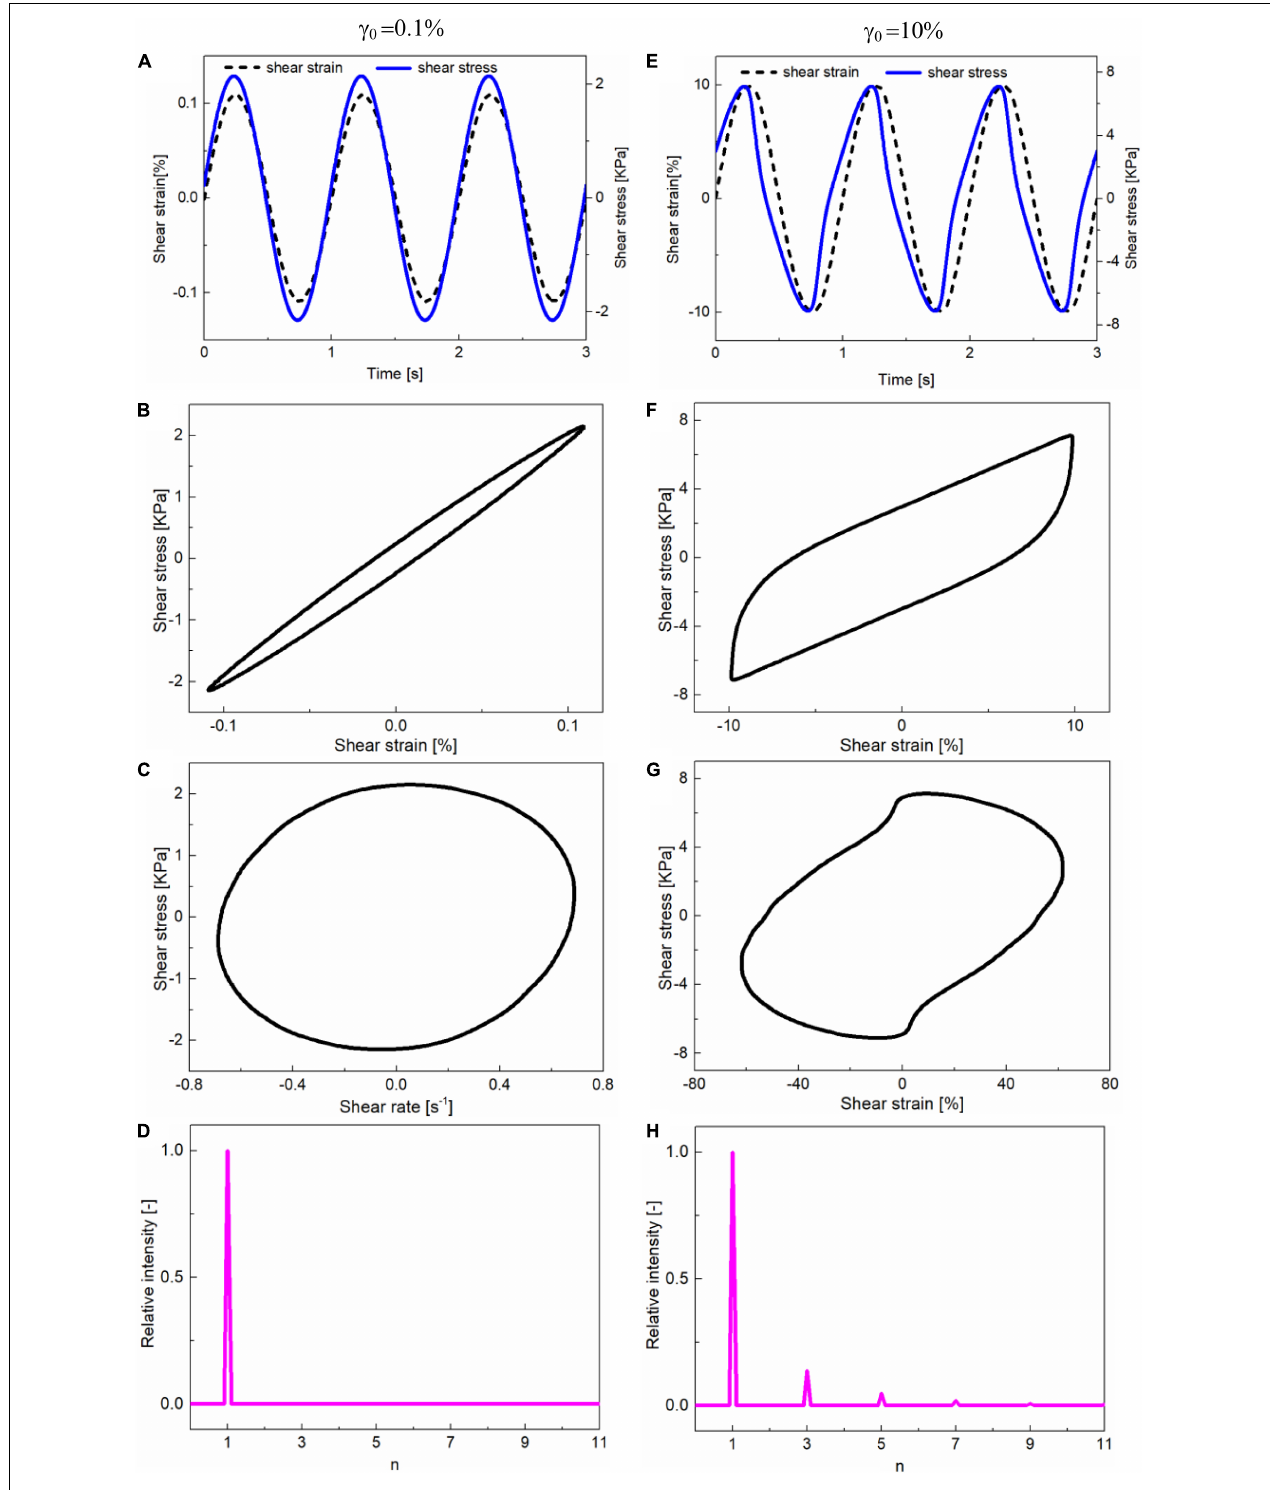
FIGURE 3 | (A,E) represent the dependence of input strain and response stress on time. (B,F) show the Lissajous curves of the shear stress that varies with the shear strain (elastic Lissajous curves). (C,G) show the Lissajous curves of the shear stress that varies with the shear rate (viscous Lissajous curves). (D,H) show the results from FT-Chebyshev analysis. The data used in (A–D) were obtained from the LAOS test with γ = 0.1% and f = 1 Hz. The data used in (E–H) were obtained from the LAOS test with γ = 10% and f = 1 Hz. All these tests were conducted on the magnetic field of 391 kA/m.